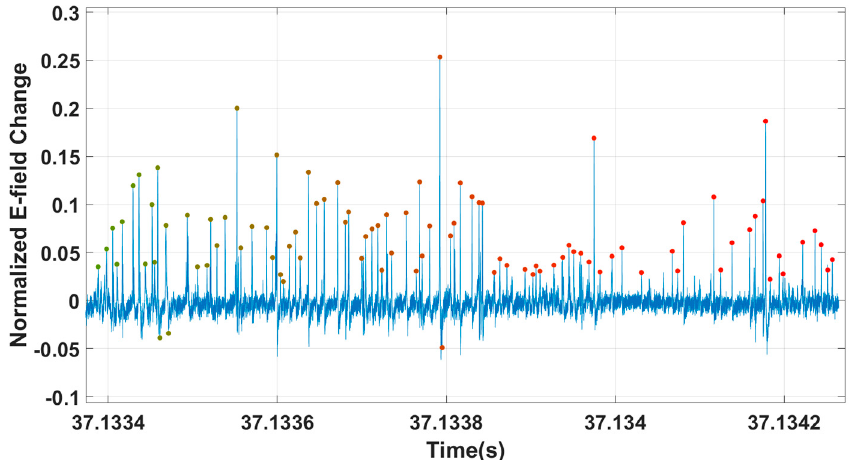
Figure 5. Part of the normalized electric field waveform of IC flash 001136 detected by the station MD and these 93 extracted pulses.